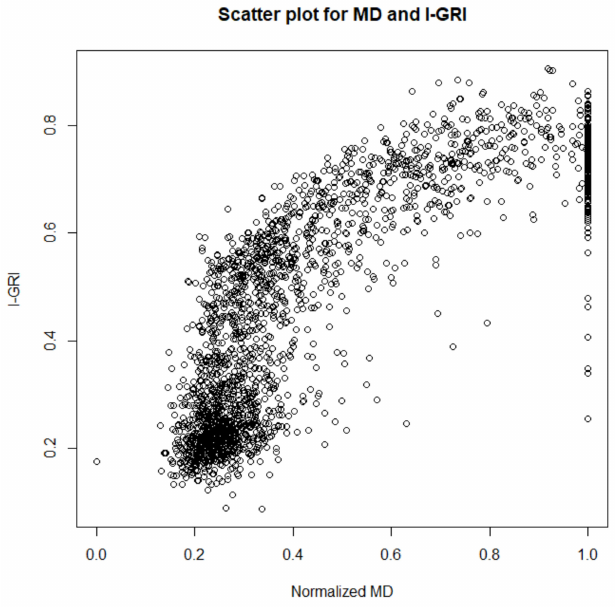
Figure 9. Scatterplot of the MD of the glaucoma group and the I-GRI.